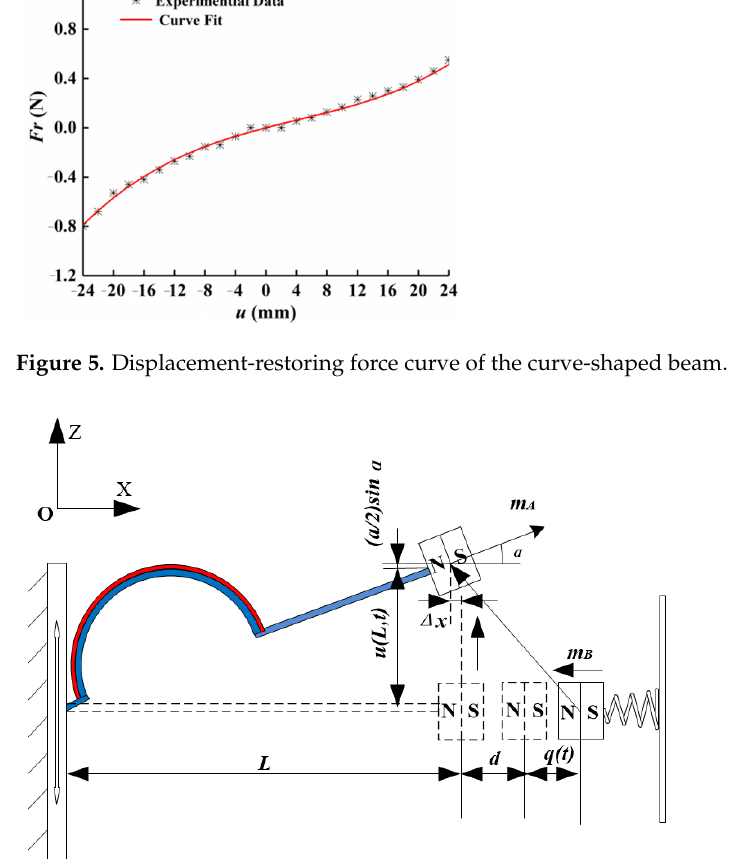
Figure 5. Displacement-restoring force curve of the curve - shaped beam.